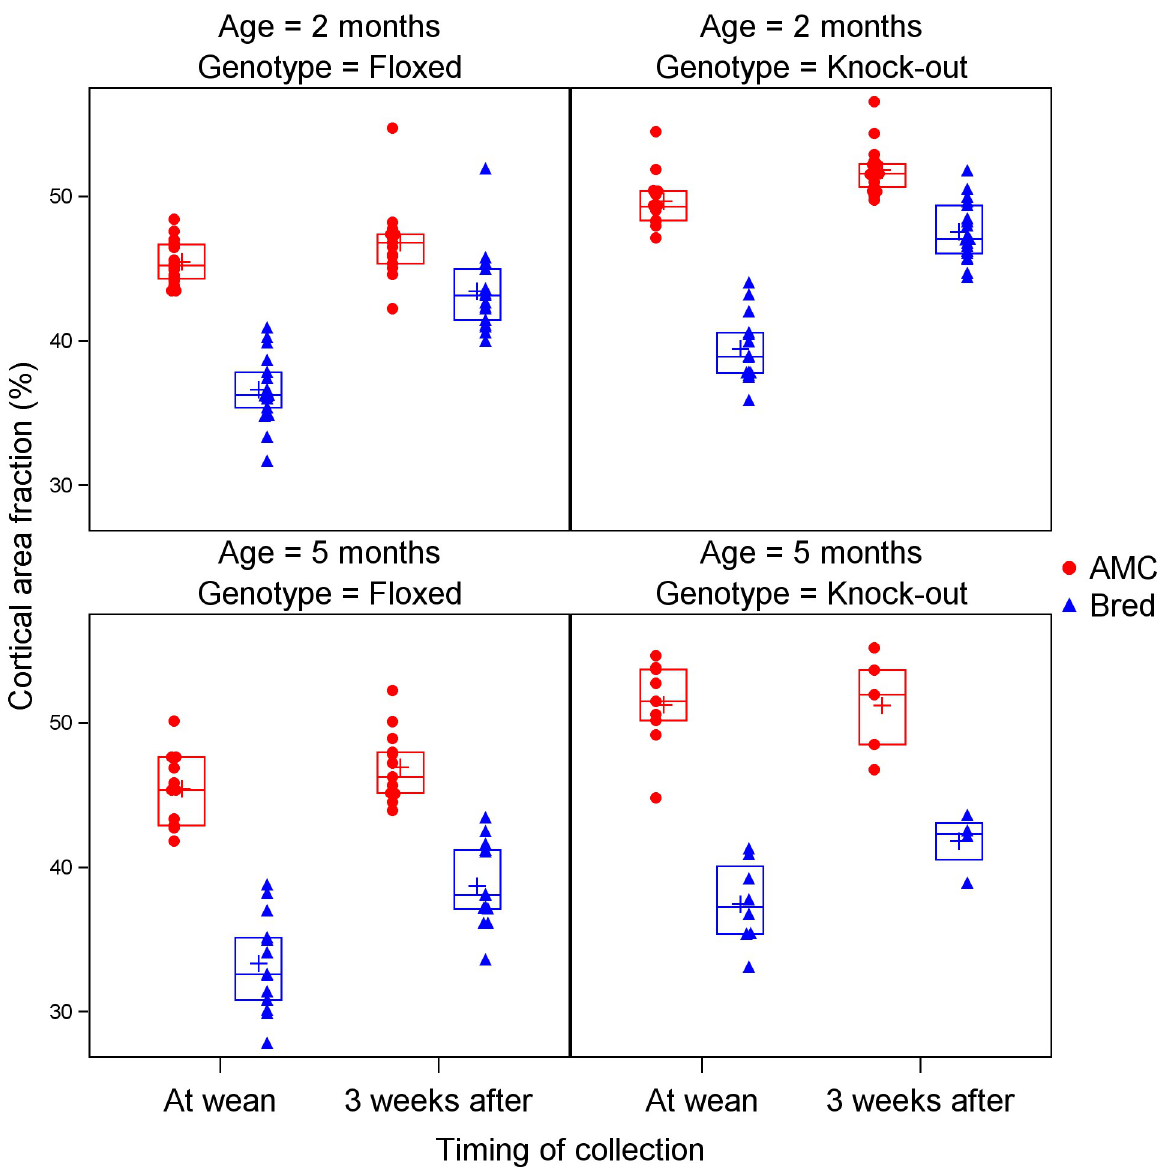
Fig 2. Effects of age, Pappa2 genotype, lactation and recovery after weaning on cortical area fraction. Blue triangles denote bred mice, and red circles denote age-matched controls (AMC). Crosses denote means, while horizontal lines denote the 25th, 50th and 75th